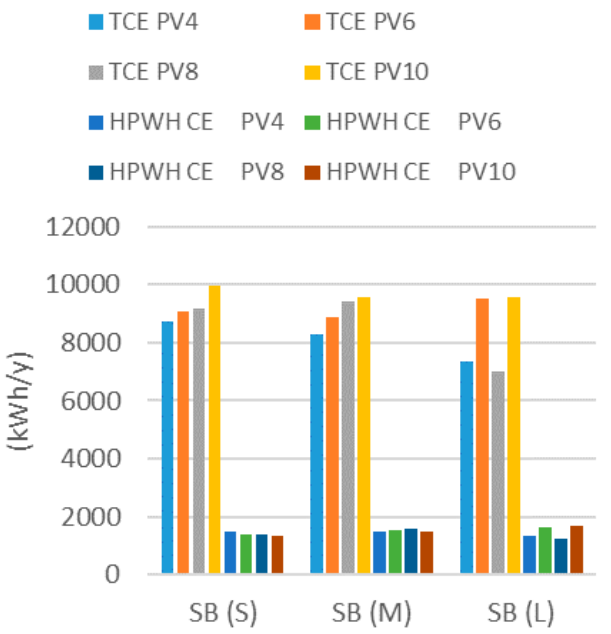
Figure 13. Annual total and HPWH consumption of SB type for PV.